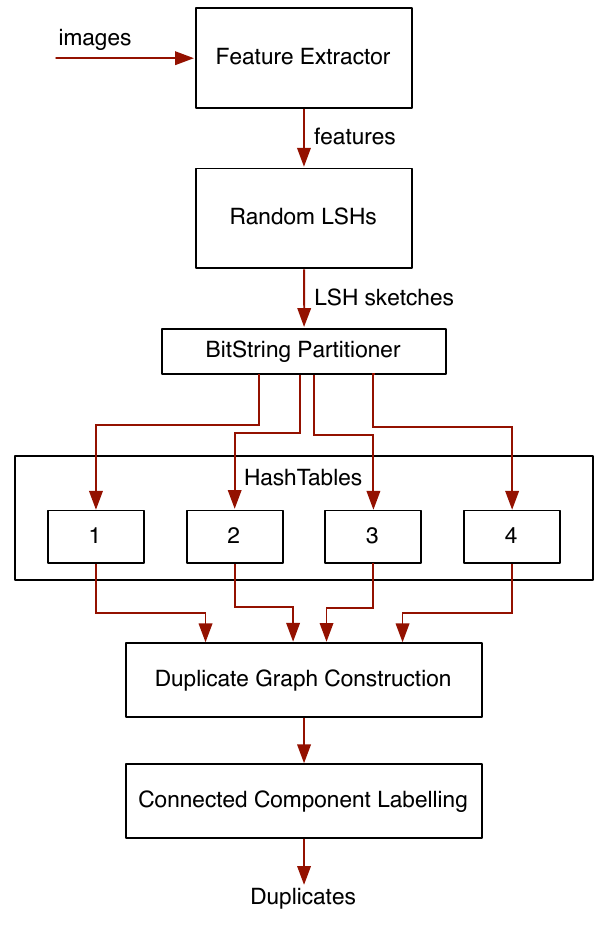
Figure 3. Process for efficiently finding near-duplicates of images (or video frames) by constructing a duplicate graph from the sketches of local features. LSH, locality sensitive